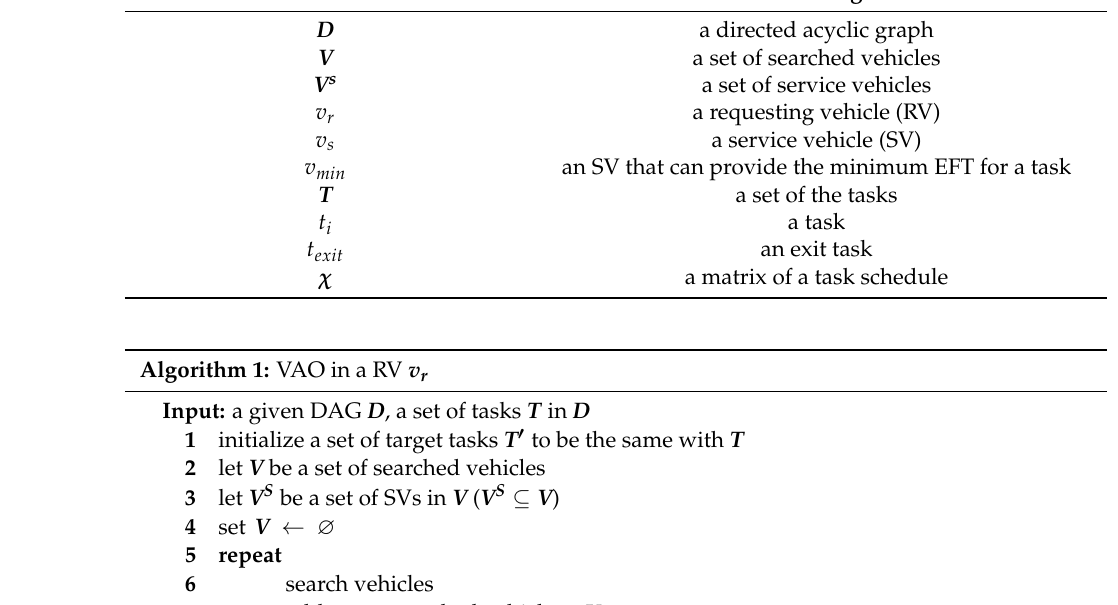
Table 2. The notations and meanings.